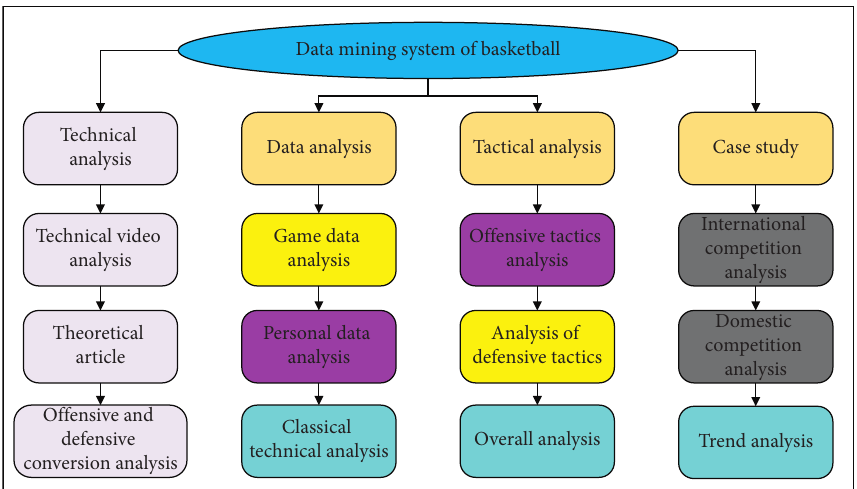
Figure 1: The mining system of basketball sports data